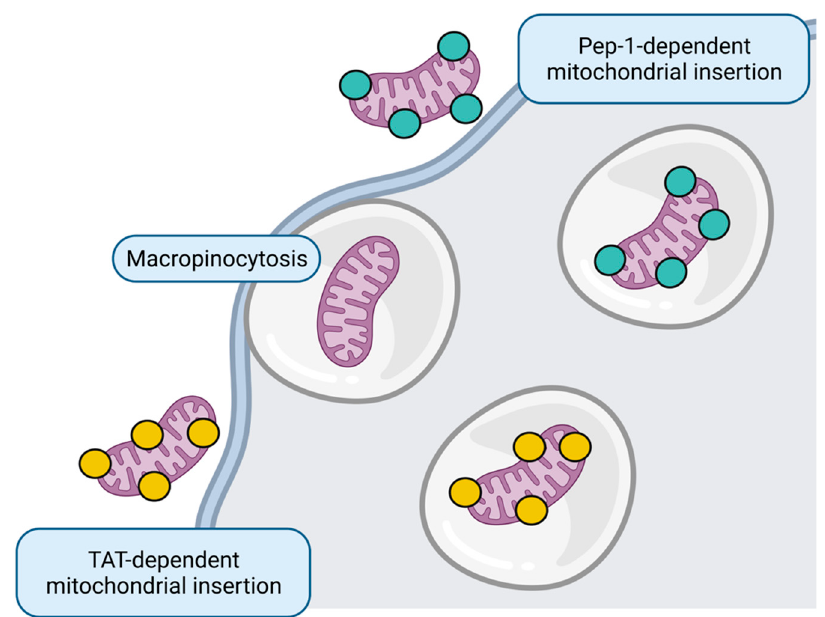
Figure 5. Mitochondrial replacement. Whole healthy mitochondria insertion to target cell could occur through micropinocytosis or directed through Pep-1 and transactivator of transcription (TAT) peptides. Figure created with BioRender.com.